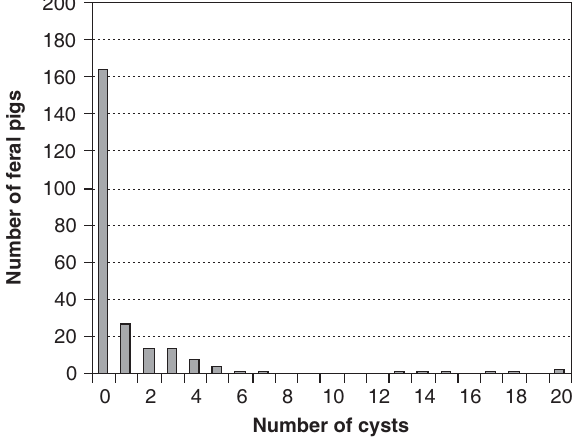
FIG. 1 Frequency distribution of hydatid cysts in feral pigs TABLE 1 Frequency distribution of hydatid cysts in infected feral pigs by sex